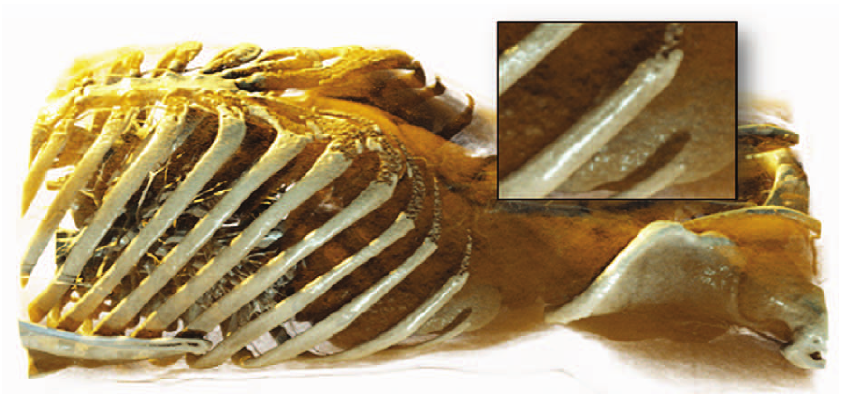
Figure 6. Image rendered with hybrid scattering. Note how detail is preserved through specular highlights, while still fully supporting volumetric scattering.